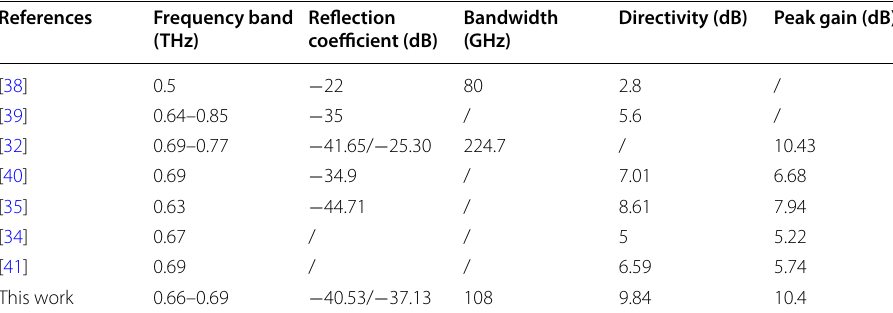
Table 4 Comparison study with existing